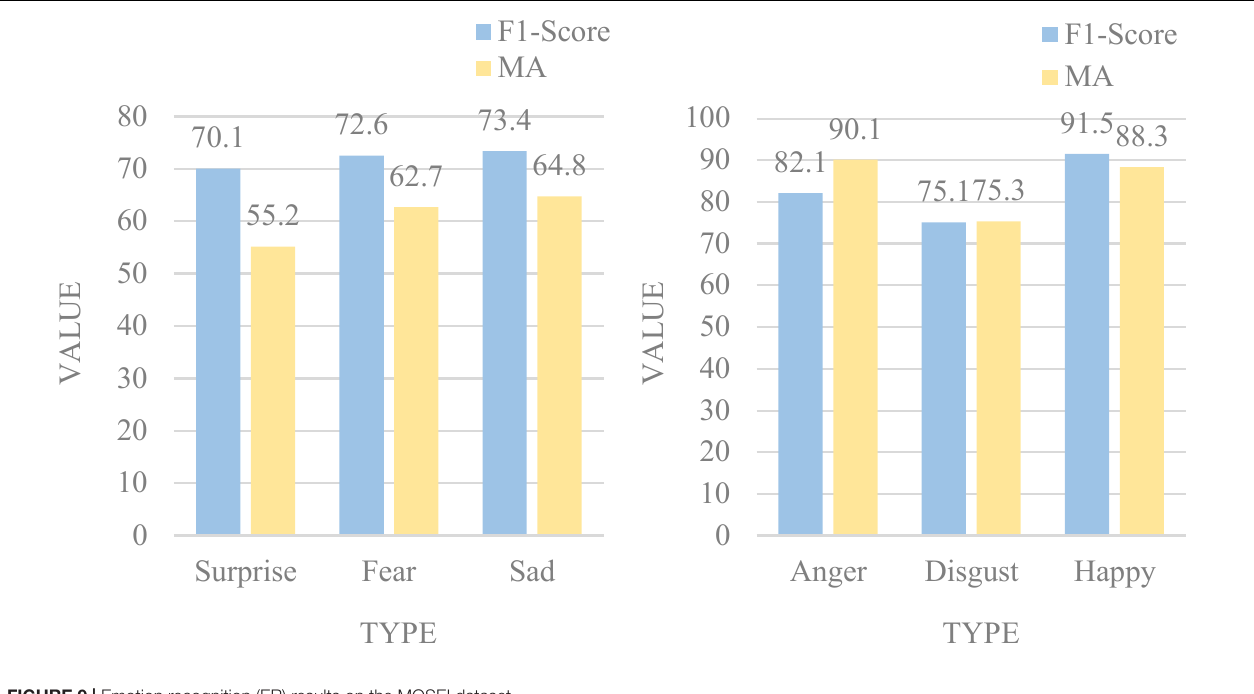
FIGURE 9 | Emotion recognition (ER) results on the MOSEI dataset.